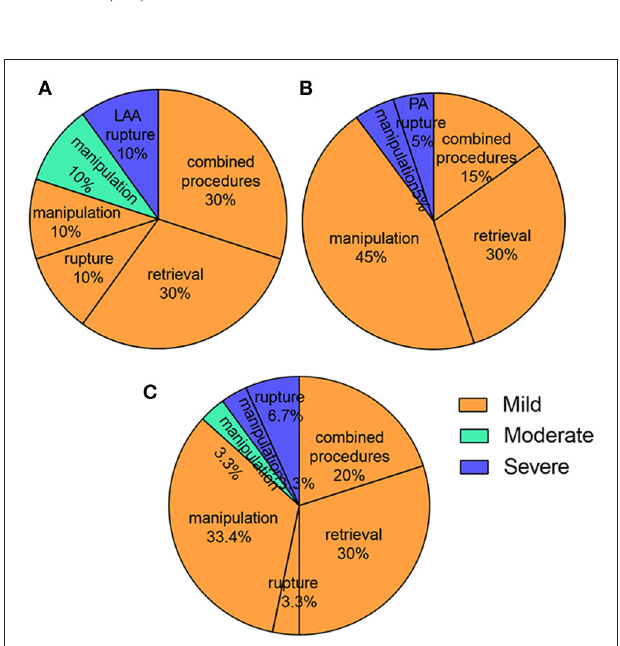
FIGURE 2 | The predictors of PE in the perioperative period. (A) Combined procedures and retrievals were the most reasons for intraoperative PE; (B) Manipulation and retrievals were the most reasons for postoperative PE; (C) Manipulation, combined procedures and retrievals were the most reasons for all